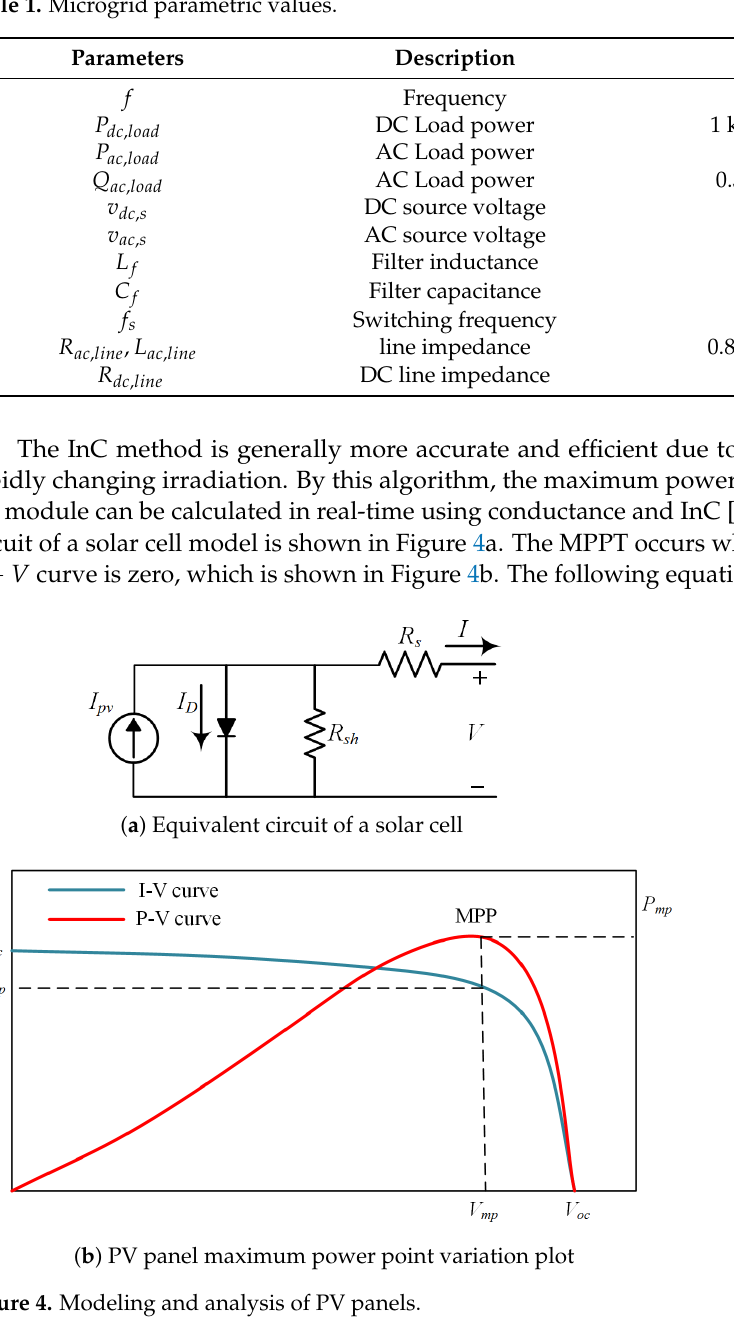
Table 1. Microgrid parametric values.